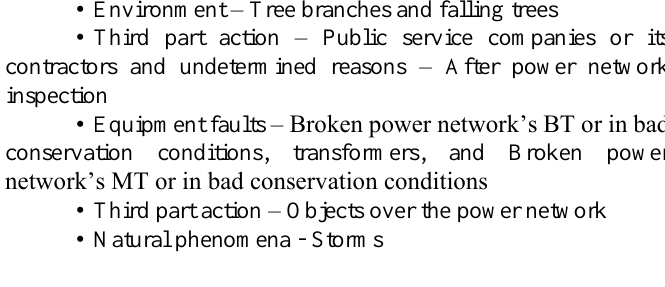
Figure 5: Graphic of the Fault frequency.